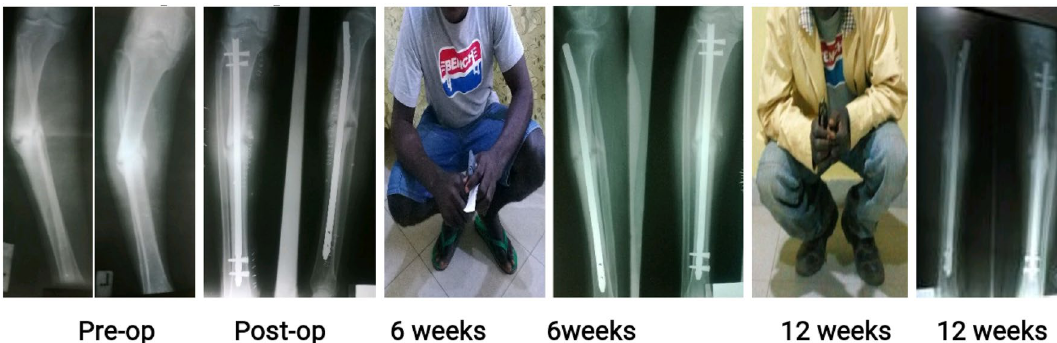
Figure 5. A 34-year old heavy construction machinery operator with hypertrophic non-union of a 42-A3 fracture operated 11.64 months post-injury. He was back at work immediately after the 6th week follow-up visit in spite of absent radiological